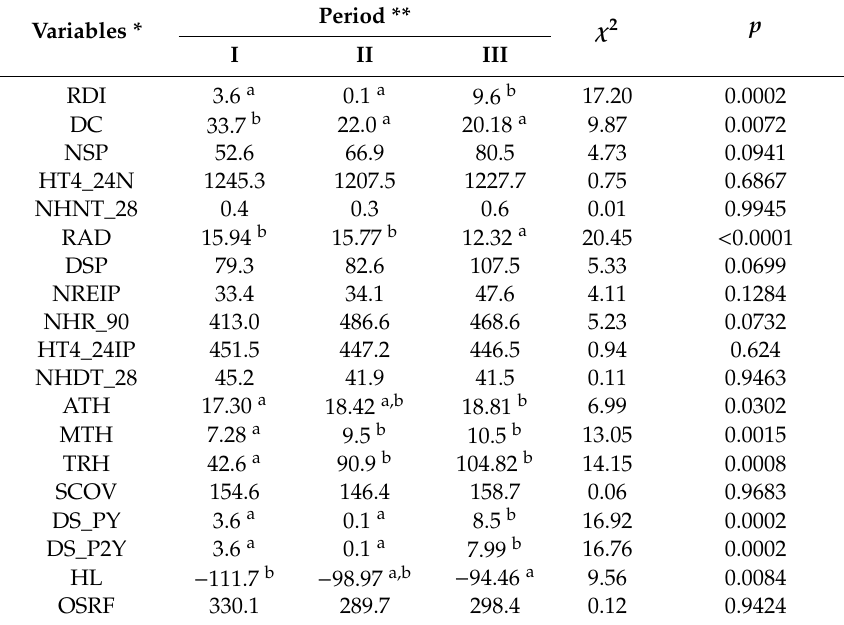
Table 2. Mean values of regional disease incidence (RDI) and weather-related variables, and results of theKruskal–Wallistest(observedvalueoftheteststatisticandcorrespondingprobabilityofsignificance).